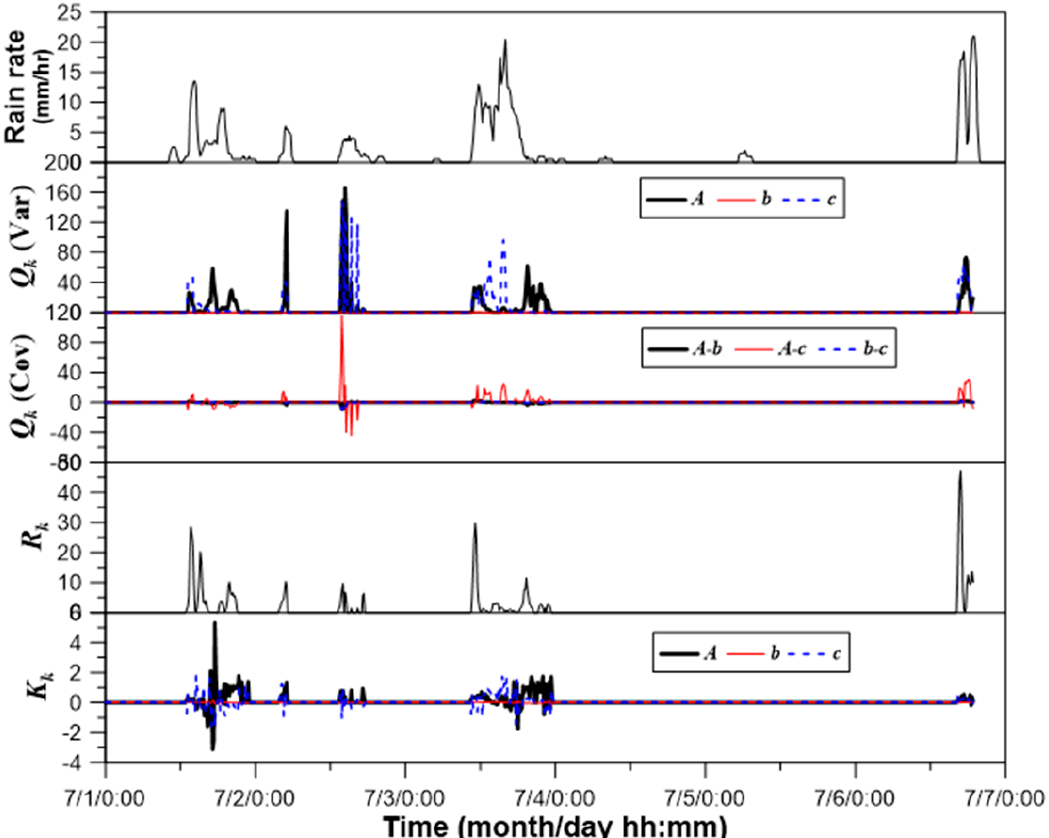
Figure 4. Rain rate, variance and covariance of state variables, measurement error covariance, and behavior of Kalman gain at the Shinpo rain gauge station (No. 936).